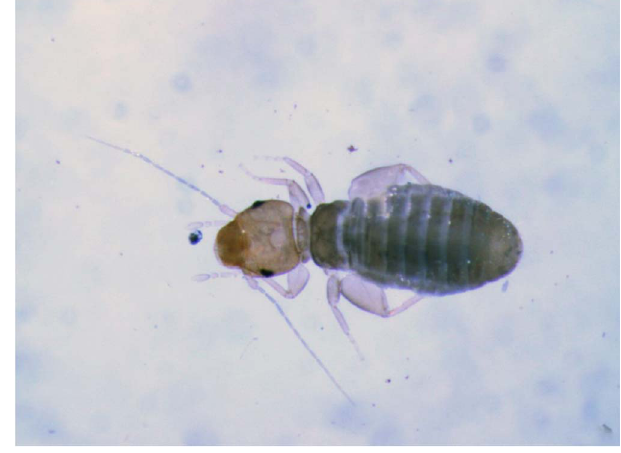
Figure 2. Psocid Liposcelis bostrychophila Badonnel, 1931 (Psocoptera, Liposcelididae) as seen on an egg paper. Photo by M. Zheng.